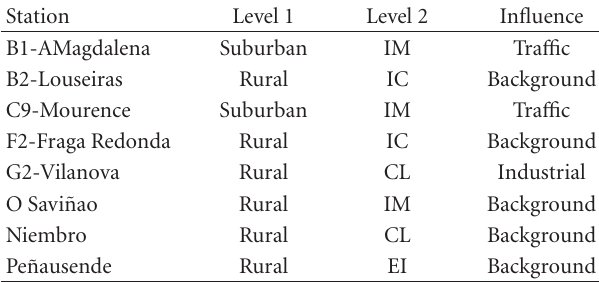
Table 6: Final classification of air quality monitoring stations; mea- surements from 2002 to 2007 were used for statistical ozone analy- sis.